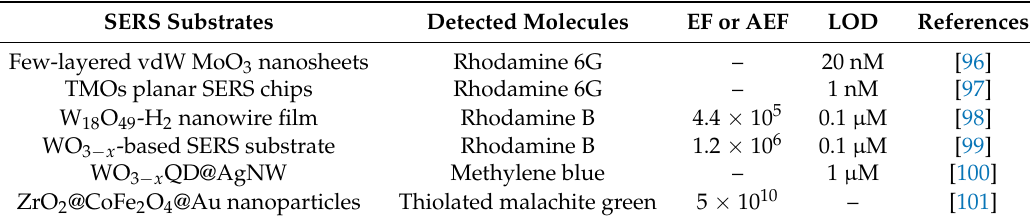
Table 4. SERS performances of metal-oxide nanostructures for biological/chemical sensing (vdW MoO 3 = van der Waals molybdenum trioxide; TMOs = transition metal oxides; W 18 O 49 = WO 2.72 = non-stoichiometric tungsten oxide; WO 3 − x = non-stoichiometric tungsten oxide; QD = quantum dot; NW = nanowire; ZrO 2 = zirconia; CoFe 2 O 4 = cobalt